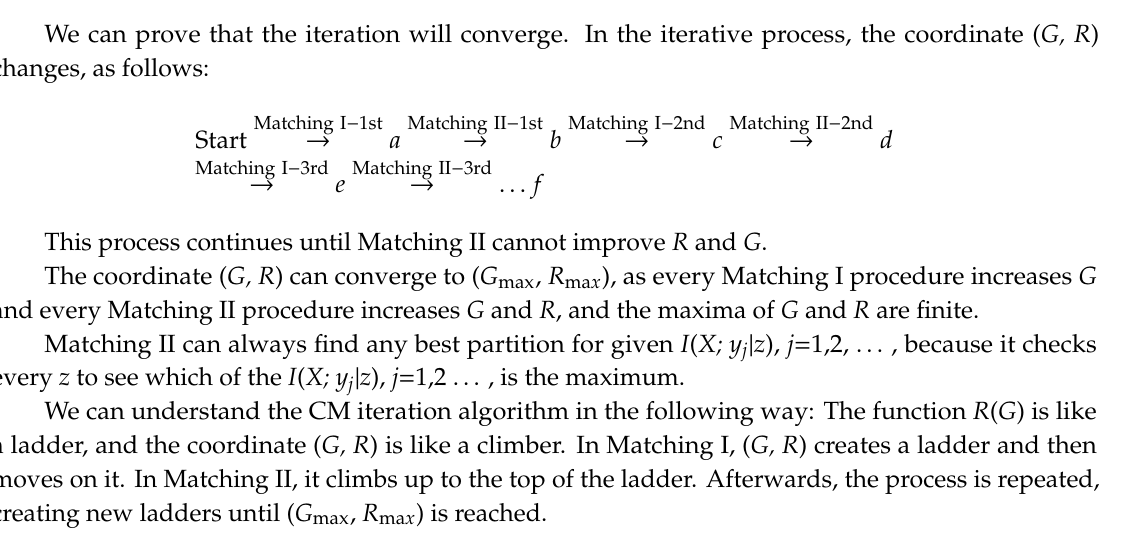
Figure 8. Illustrating the iterative convergence of the MMI classification of unseen instances. In the iterative process, ( G, R ) moves from the start point to a,b,c,d,e,…,f gradually